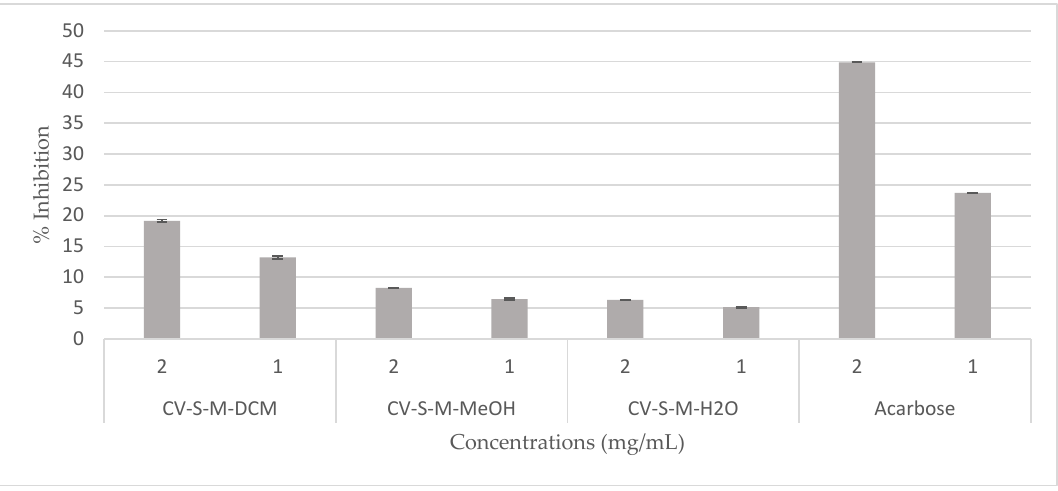
Figure 5. Hypoglycemic effect of the C. villosa stems extracts. All values are expressed as mean of triplicate ± SD.